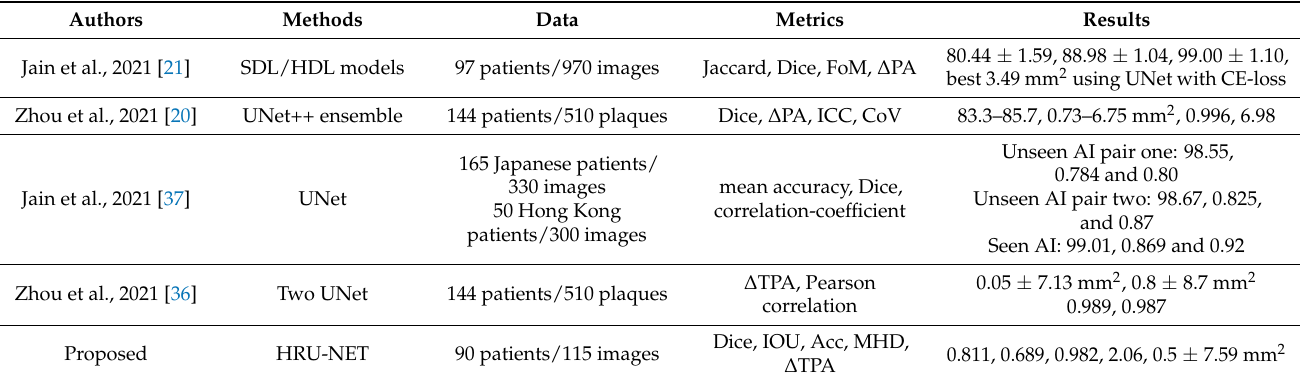
Table 7. Plaque segmentation comparison between different studies.